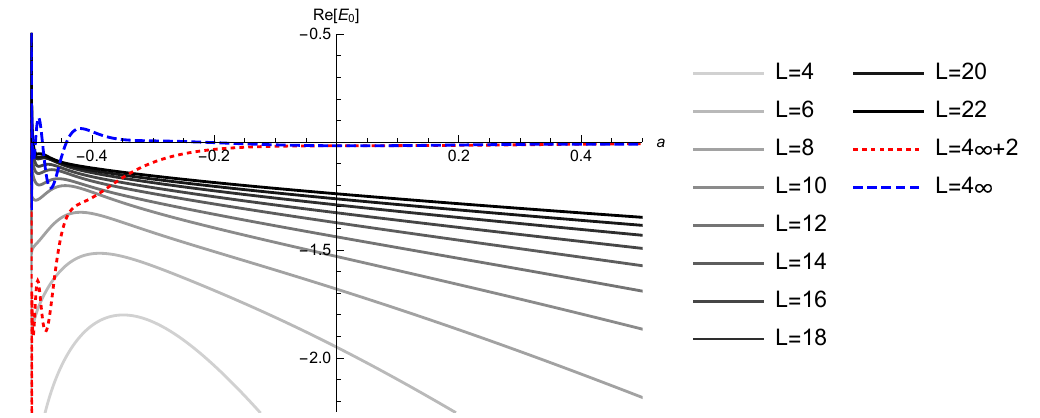
Figure 12 . Plots of the real part of the gauge invariant observable E 0 (2.17) for the “ghost brane” solution Φ G at the truncation level L . The dotted and dashed lines are extrapolations to L = 4 k +2 a ( k → ∞ ) and L = 4 k ( k → ∞ ), respectively. The horizontal axis denotes the value of the parameter a at Re E 0 = − 1